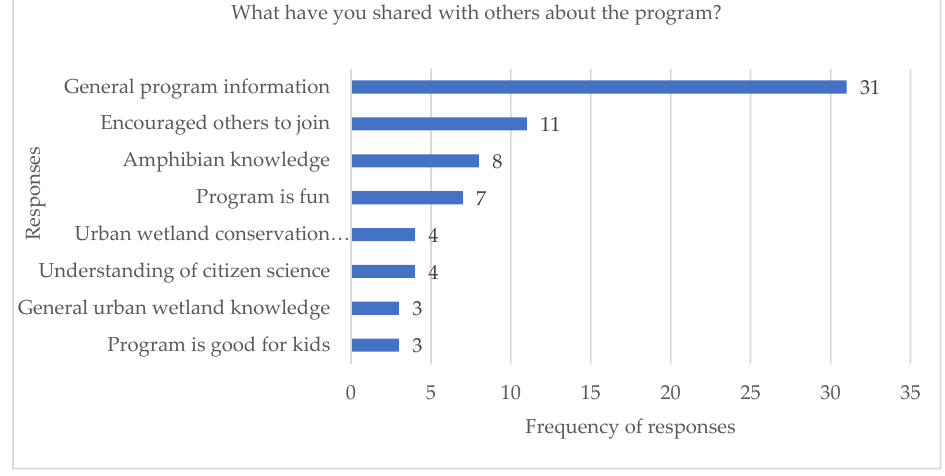
Figure 6. Frequency of coded topics found in responses to the open-ended question: “What have you shared with others about the program?”.